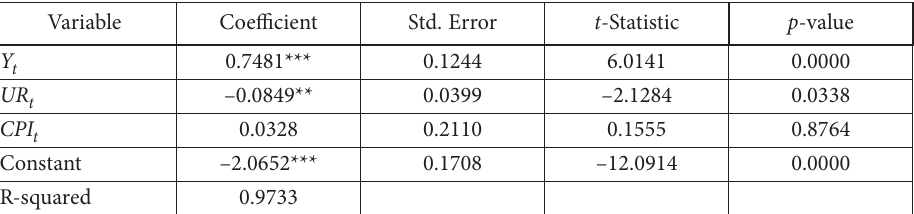
Table 3. Estimations for the equilibrium home price (FMOLS